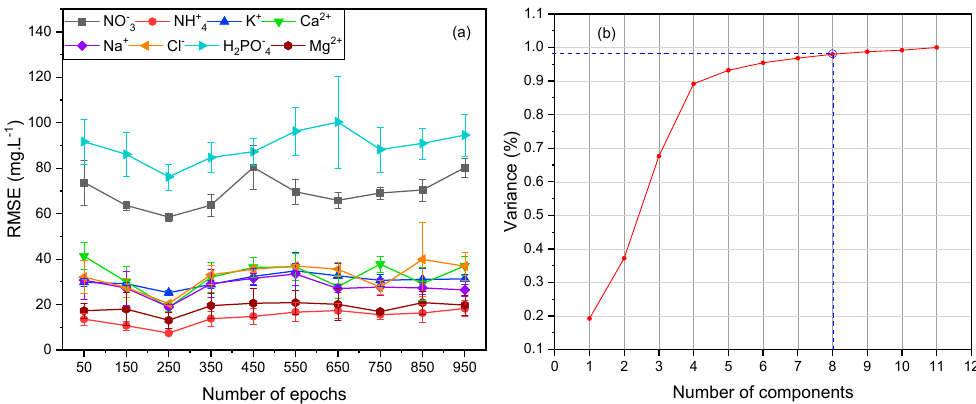
Figure 4. Relationship between the number of epochs and RMSEs ( a ) and PC components and variance of the dataset ( b ).